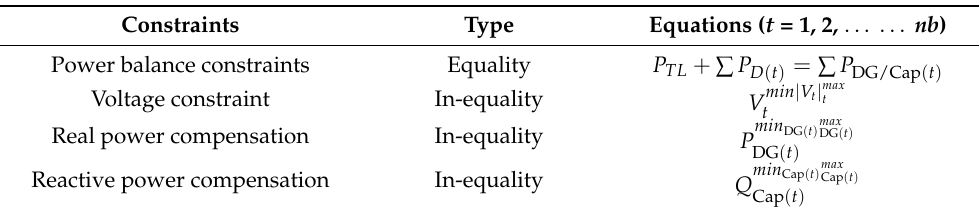
Table 2. Constraints for